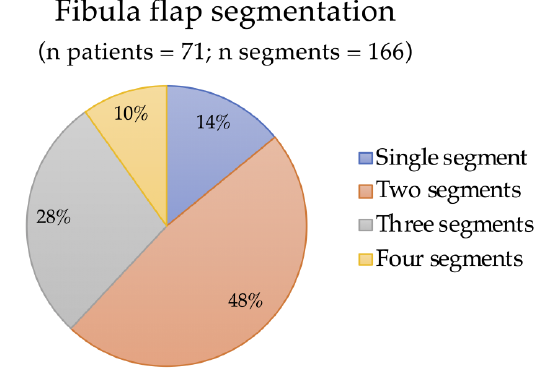
Figure 2. Fibula flap segments distribution.